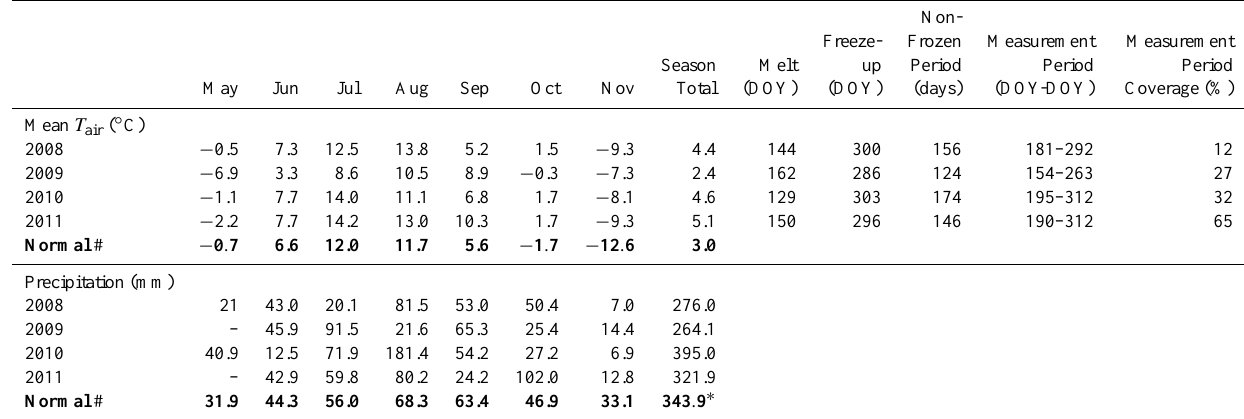
Table 1. Summary table of monthly mean air temperature ( T air ) and total precipitation compared to the 1971–2000 climate normals for Churchill, Manitoba, obtained from Environment Canada, onset date of melt and freeze-up, duration of non-frozen period and measurement period duration and % coverage. – represents no data available; ∗ represents 312mm precipitation for June to November for use in 2009 and 2011 comparisons.